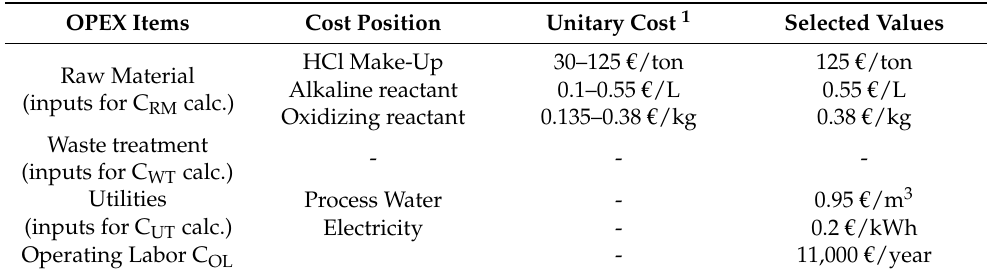
Table 4. Unitary costs for OPEX